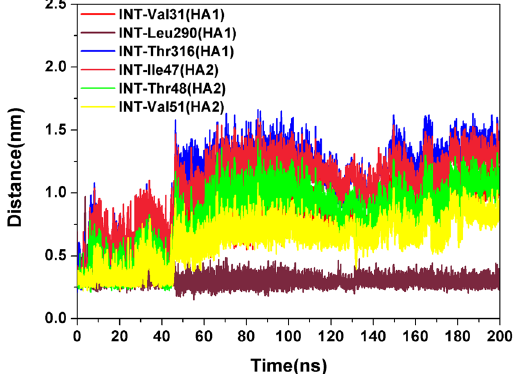
Figure 7. Distances between INT and residues (HA1-Val31, HA1-Leu290, HA1-Thr316, HA2-Ile47, HA2- Thr48 and HA2-Val51) under acidic conditions.